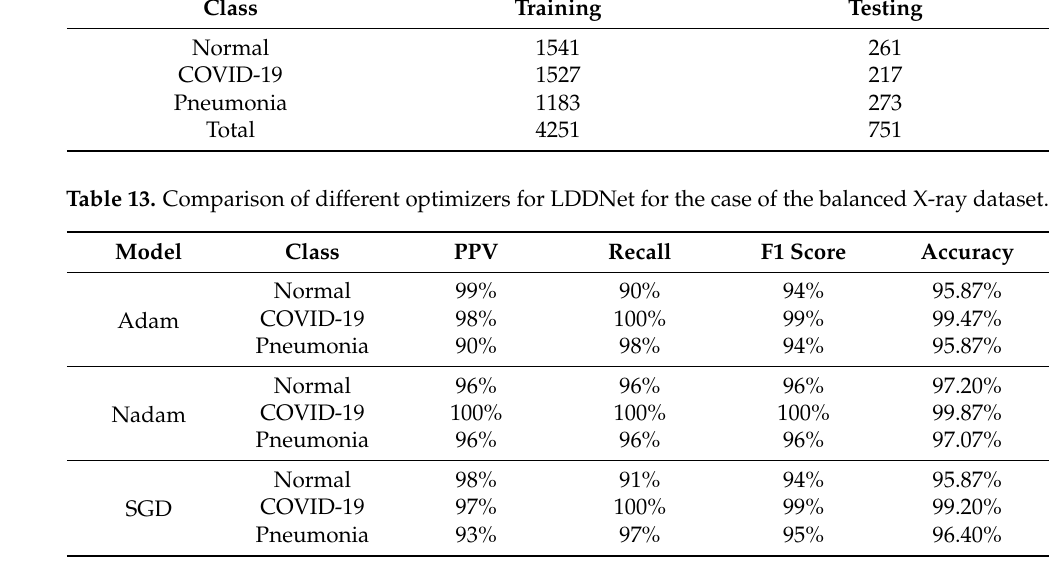
Figure 9. ROC curve for LDDNet: ( a ) Adam optimizer, ( b ) Nadam optimizer, and ( c ) SGD optimizer.